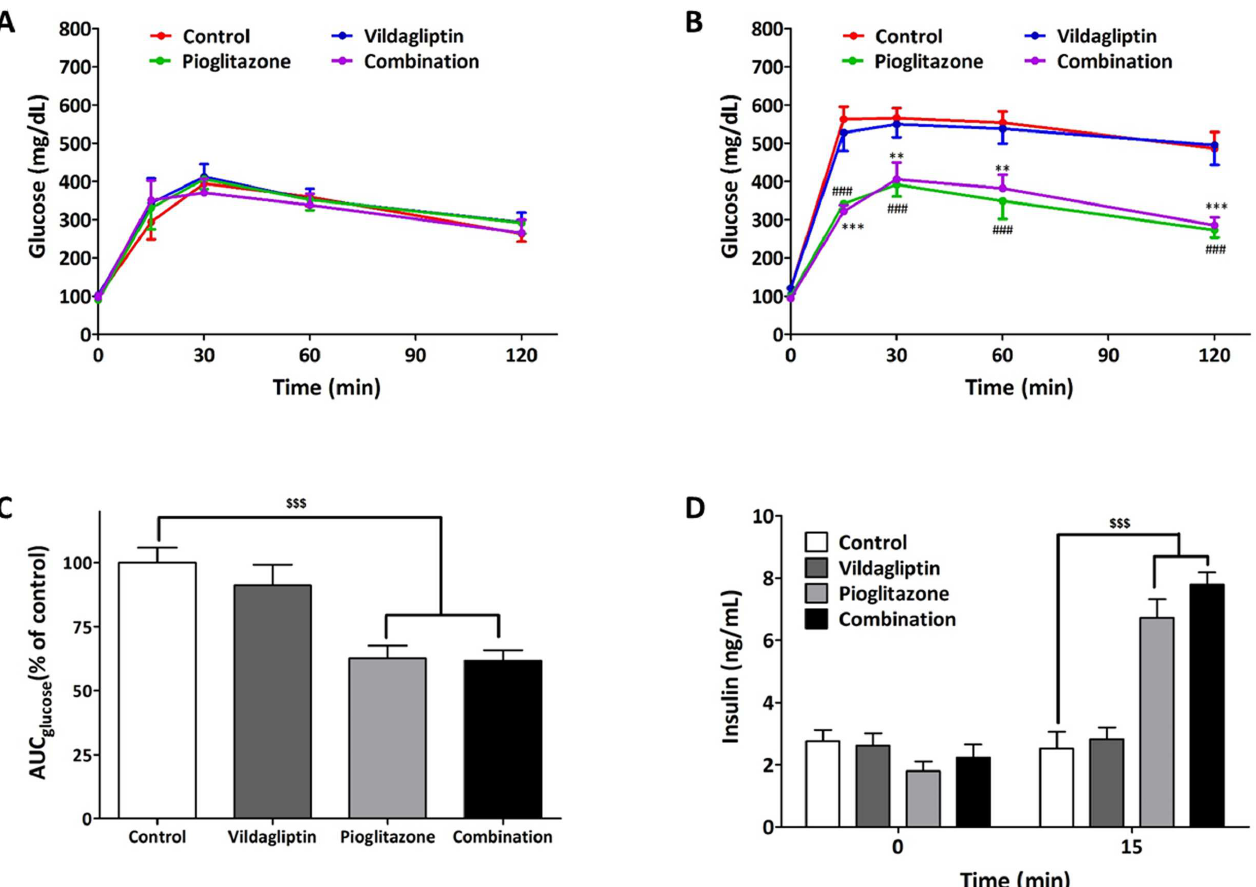
Fig 2. Glucose profile and insulin secretion after 5-week treatment in ZDF rats. (A) Glucose profile in IPGTT (glucose2g/kg) before treatment (B) Glucose profile in IPGTT (glucose2 g/kg) after treatment with control, vildagliptin(10 mg/kg/day), pioglitazone (30 mg/kg/day), and combination (vidalgliptin10 mg/kg/day and pioglitazone 30 mg/kg/day). (C) AUC of glucose duringthe IPGTT after treatment (D) serum insulinlevel at 0 and 15 min in IPGTT after treatment. All data representedas Mean ± SD. ** p < 0.01 and *** p < 0.001 (combination group) and ### p < 0.001 (pioglitazone group) comparedwith control group. $$ p < 0.01, $$$ p < 0.001 comparedwith control